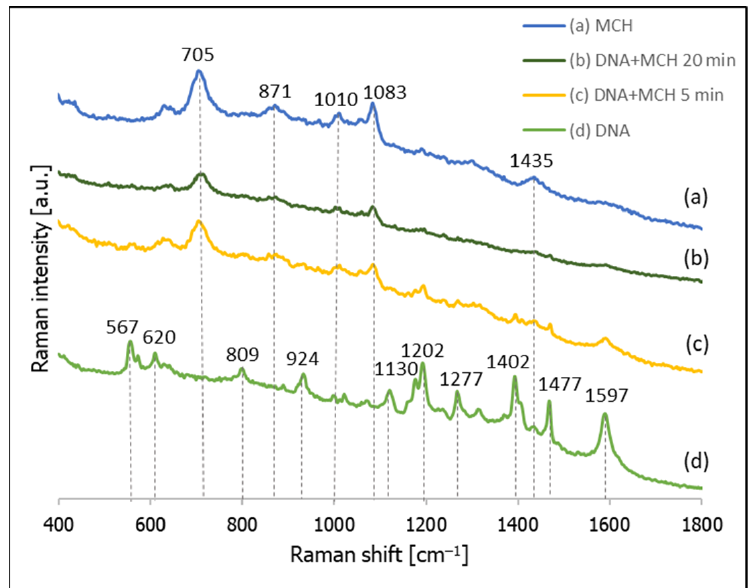
Figure 7. SERS spectra of layers formed on a nanostructured silver electrode from: ( a ) a 10 mM MCH solution, ( b ) thiolated DNA labelled with Cy3 and immersed for 20 min in a 10 mM MCH solution, ( c ) thiolated DNA labelled with Cy3 and immersed for 5 min in a 10 mM MCH solution, and ( d ) thiolated DNA labelled with Cy3.